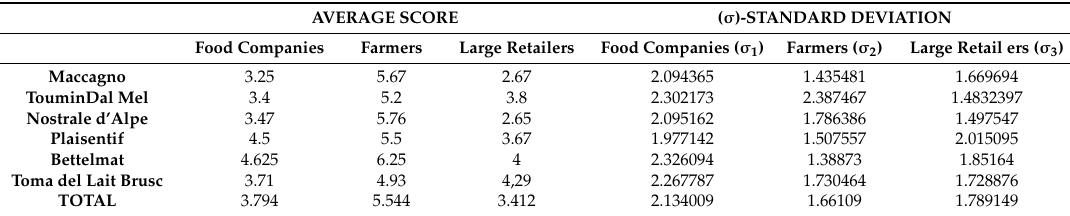
Table 1. The farmers’ perception of how useful it is to adopt the term “mountain product” for some market operators, in the reply to the question : “In your opinion, how useful is the OQT mountain product label for (assigning value from 1 to 7; 1 = strongly disagree, 7 = strongly agree): large food companies, small farms, large retail